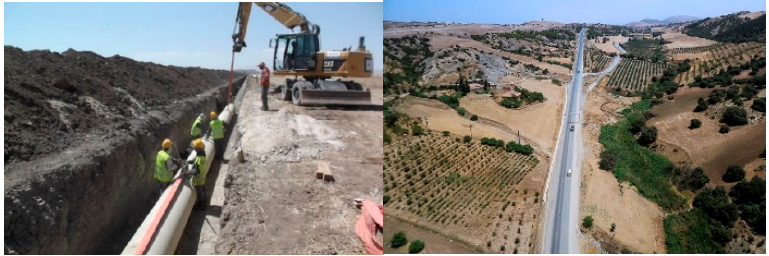
Figure 12. Installing 30 km pressure pipes for increasing Algeria’s food security. https://www. amiblu.com/reference/30-km-pressure-pipes-for-irrigation-project-in-algeria/borgenproject.org, Creative Commons, Public Domain.